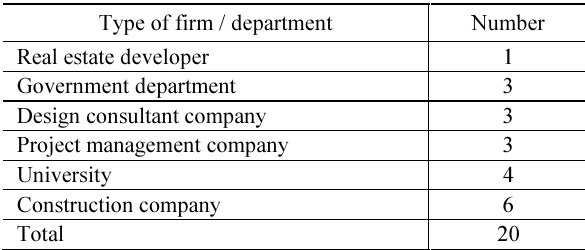
Table 1. List of the experts for the Delphi study